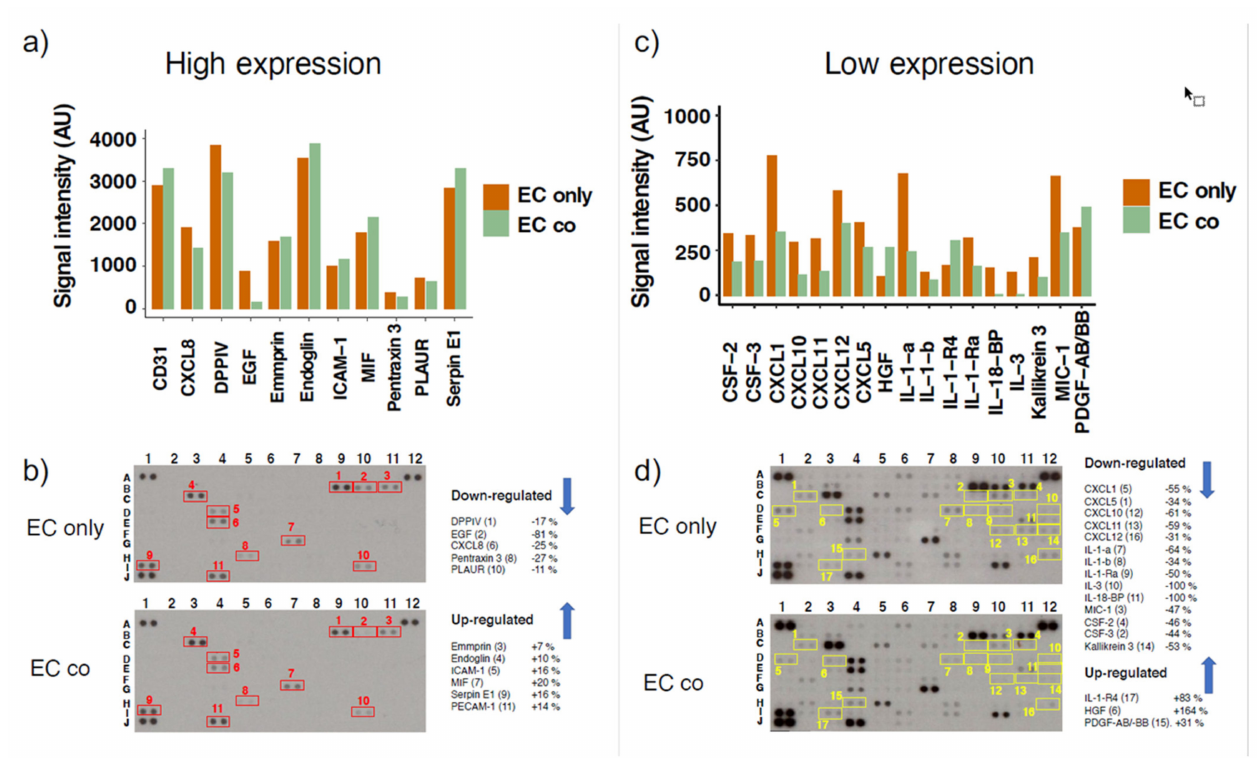
Figure 7. Differential expression of several cytokines in mono- and co-cultured endothelial cells (ECs). Proteome analysis has been performed using the Proteome Profiler Human XL Cytokine Array Kit using equal amounts of cell lysates from ECs cultured alone (EC only) and in co-cultures with pericytes (EC co). Representative array blots are shown after a short exposure time of 3 min ( b ) and after long exposure time of 25 min ( d ). Bar graphs show the average signal intensities of the framed spots on the array blots and include measurements of two independent experiments at high ( a ) and low ( c ) exposure times, respectively. The legends on the right of the array blots denote the proteins as numbered in the respective blots. Analysis was performed with the image processing software ImageJ (including background subtraction). Experiment was performed twice with independent